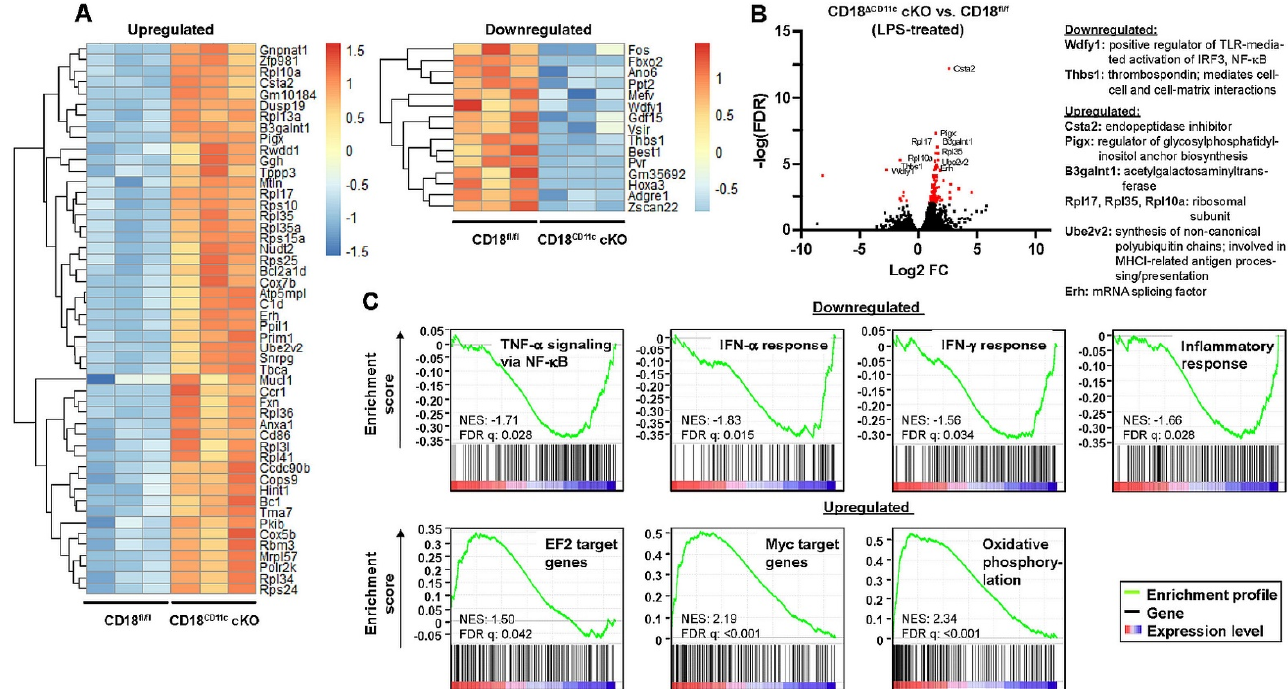
Figure 5. Downregulation of β 2 integrins in BMDCs results in attenuated expression of genes associated with inflammatory signaling and upregulation of genes involved in metabolic pathways, as well as transcription factor Myc/EF2 targets. LPS-stimulated BMDCs (CD18 fl/fl and CD18 CD11c cKO, each n=3) were subjected to RNA-seq analysis. ( A ) Heatmap representation of the top 50 significantly upregulated (left panel) and significantly downregulated (right panel) genes in CD18 CD11c versus CD18 fl/fl BMDCs (hierarchical clustering). The color legend denotes the level of gene expression (low: blue; high: red) and represents z -scores. ( B ) Volcano plot of all quantified mRNA species. Significantly regulated genes ( t -test q -value < 0.05 and log2(fold-change) > 2) are given in red. The top 10 genes are named. ( C ) Gene set enrichment plots of significantly regulated pathways (FDR adjusted q -values < 0.05). The normalized enrichment score (NES) and FDR q -values are given.